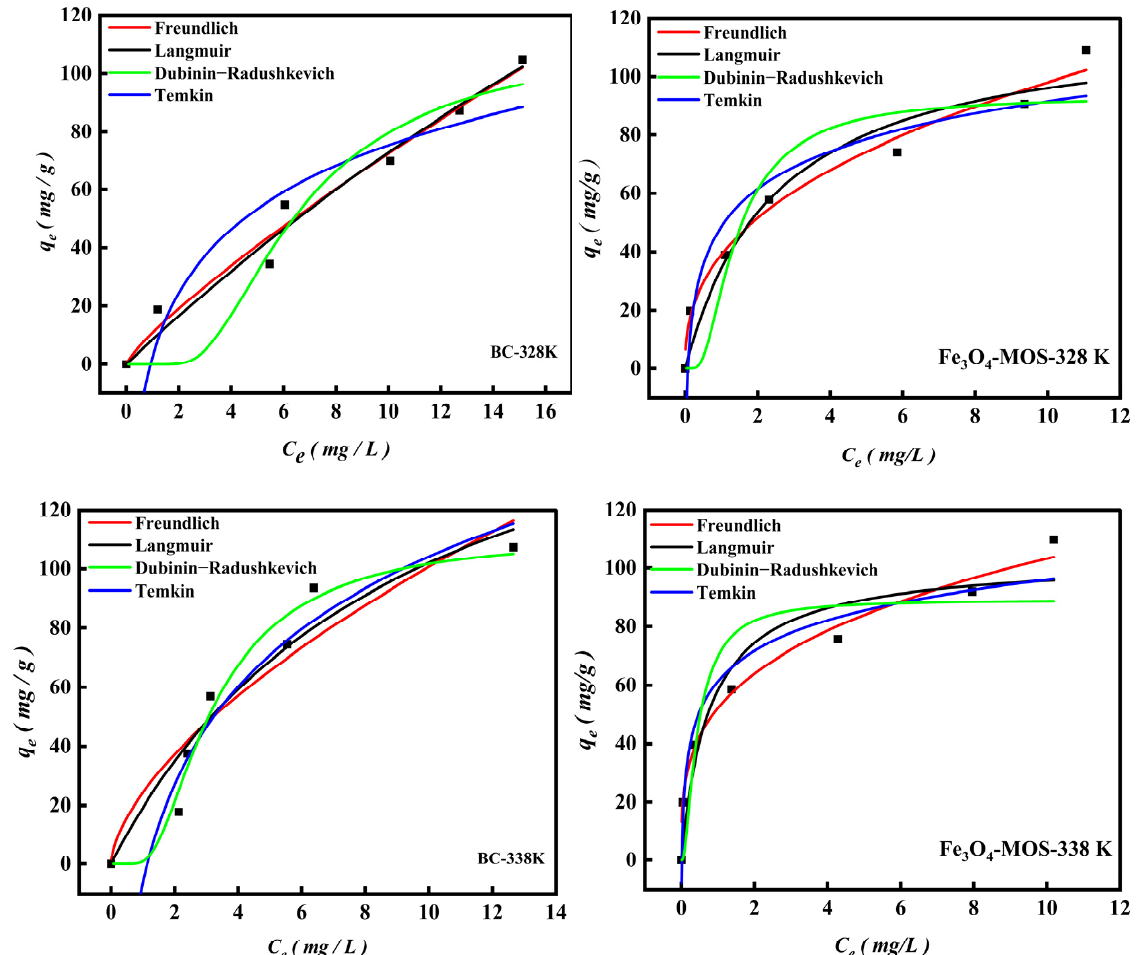
Figure 11. Non-Linear plot of Langmuir, Fredunlich, Temkin and D-R models for the adsorption of MB onto BC and Fe 3 O 4 -MOS composites at 298 K, 308 K, 318 K, 328 K and 388 K. Table 3. The parameters of the isothermal model for adsorption of MB onto Fe 3 O 4 -MOS and BC.